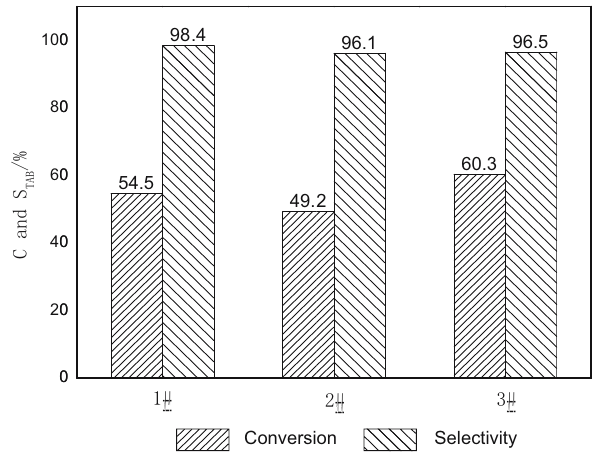
Figure 9: Contrast experiment of catalyst